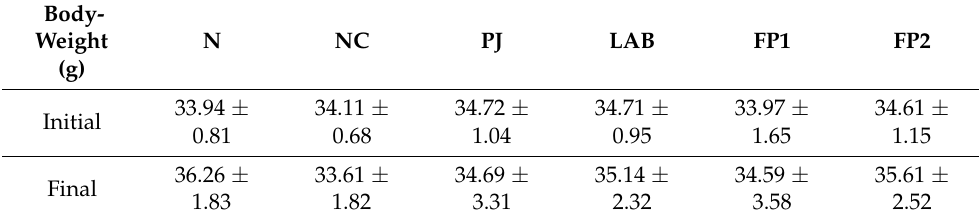
Figure 4. Colon length and lipid peroxidation after supplementation of FP to DSS-induced colitis mice. ( A , B ) Representative photos and length of the colons of the normal group and DSS-induced colitis mice supplemented with and without FP compared to the DSS control group. ( C ) Malondialdehyde contents in liver of the normal group and DSS-induced colitis mice supplemented with and without FP compared to the DSS control group. N, normal group, non-DSS treatment; NC, negative control group, DSS treatment and supplementation with distilled water; PJ; Prunus mume juice (PJ) group, DSS treatment and supplementation with 200 mg/kg of 2.5% PJ; LAB, lactic acid bacteria (LAB) group, DSS treatment and supplementation with 200 mg/kg of L. plantarum and L. casei suspended by distilled water; FP1, low dose of fermented Prunus mume juice (FP) group, DSS treatment and supplementation with 100 mg/kg of FP; FP2, high dose of FP group, DSS treatment and supplementation with 200 mg/kg of FP. Scale bars: 1 cm. Data values are expressed as the means ± S.D. ( n = 6). The data are analyzed with one-way ANOVA and different letters on the bar show the difference in Duncan’s multiple range test ( p < 0.05). Table 3. Changes of body weight after in vivo